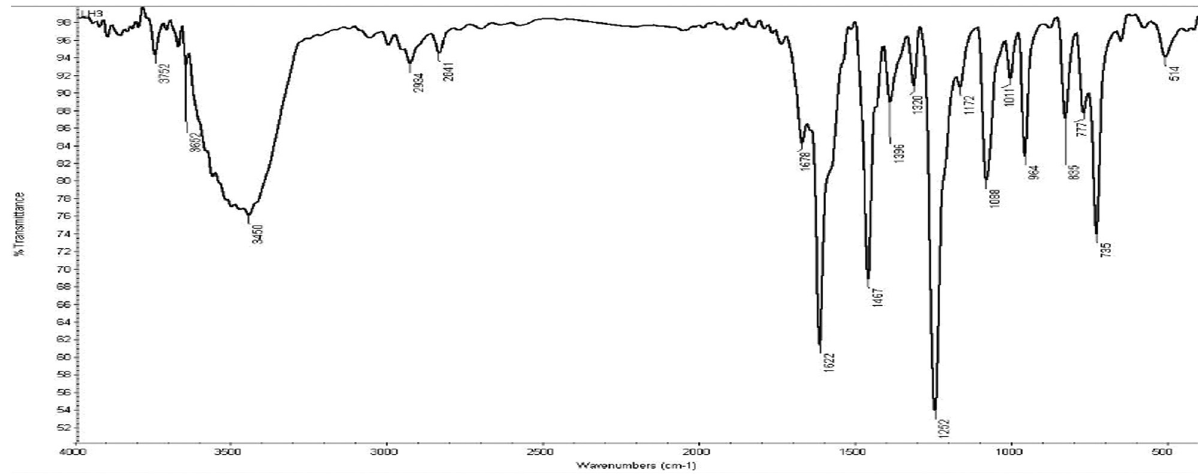
Figure 3: Infrared spectrum of the methoxy - diim free ligand.